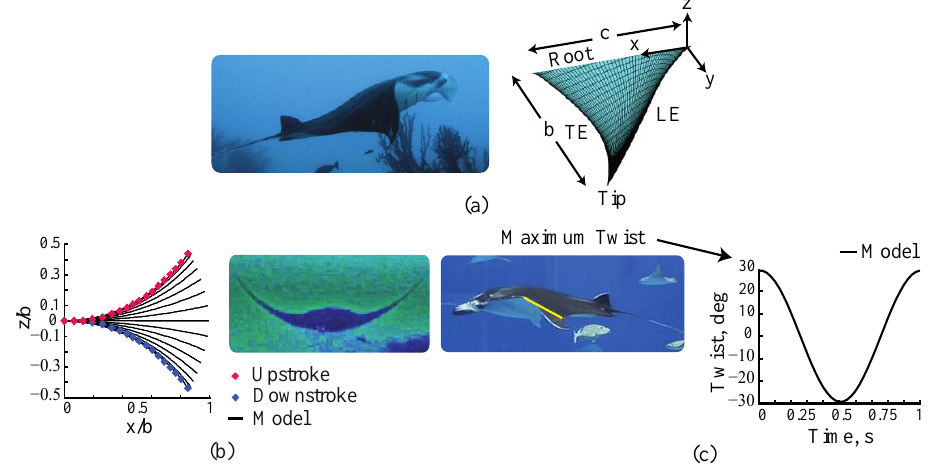
Figure 1. ( a ) Schematic showing the orientation of a pectoral fin relative to a ray and the coordinate system for the kinematic model; ( b ) Image of a manta maximum upstroke and the normalized data extracted from the image compared to the at different time steps; ( c ) Lateral image of a manta at half-cycle and the model twist angle at 3/4 span over a flapping cycle An analytical kinematic model is derived by mapping the coordinates of the flat fin to the coordinates of the deformed fin at some time, t . There are three key features that the model captures: curved spanwise deformation, near zero strain in the span direction during deformation and a chordwise traveling wave.